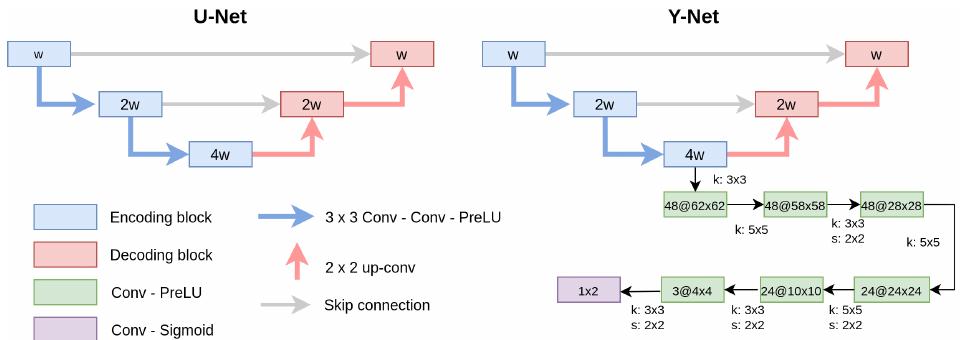
Figure 2. U-Net and Y-Net architectures. Y-Net jointly estimates the dense-tissue mask and the segmentation parameters ( α and th F ) needed to segment the dense tissue with a threshold-based tool. The channel width (w), kernel (k) and the stride (s) size for each layer are shown for the parallel branch incorporated in